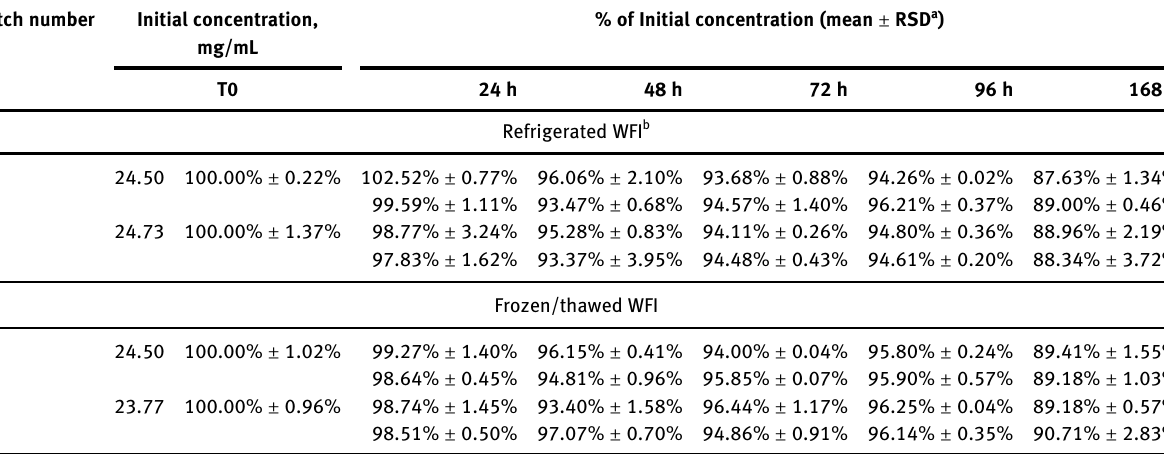
Table  : Chemicalstabilityofazacitidinesuspensions,preparedwithazacitidine vialsstoredatroomtemperature and  mg/mLazacitidine